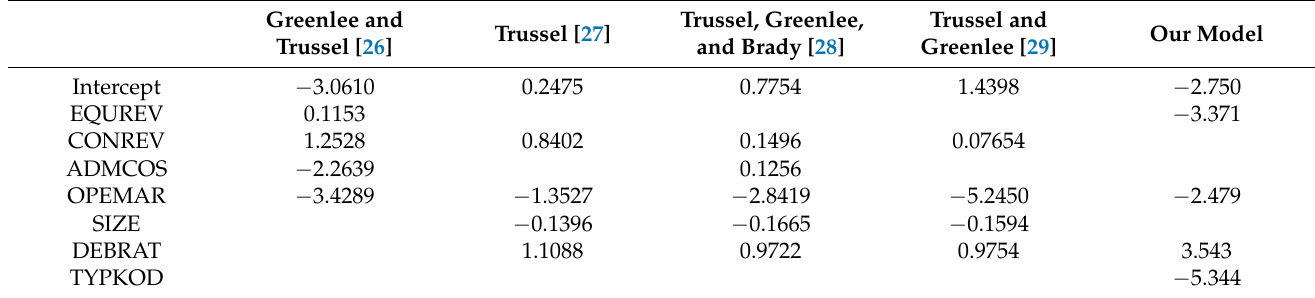
Table 13. Comparison of the proposed model with foreign